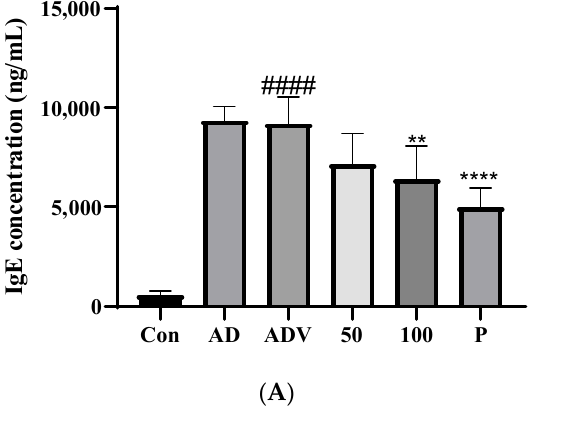
Figure 8. Effect of SLPY on IgE and IgG2 concentration of DNCB-treated AD mice. ( A ) Serum IgE level of AD mice against the control and SLPY treatment groups. ( B ) Serum IgG2a level of AD mice against the control and SLPY treatment groups. Data represent mean ± SD of at least three replicates. Signi fi cant di ff erences in each treatment group indicated based on Dunne tt ’s multiple comparison post hoc analysis. #### p < 0.0001 and # p < 0.05 vs. the corresponding control group and **** p <